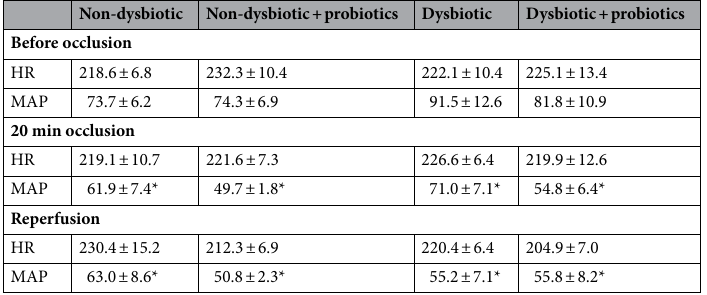
Table 2. Hemodynamic data. HR heart rate (beats/min), MAP mean arterial pressure (mm Hg). *p < 0.05 compared to before occlusion